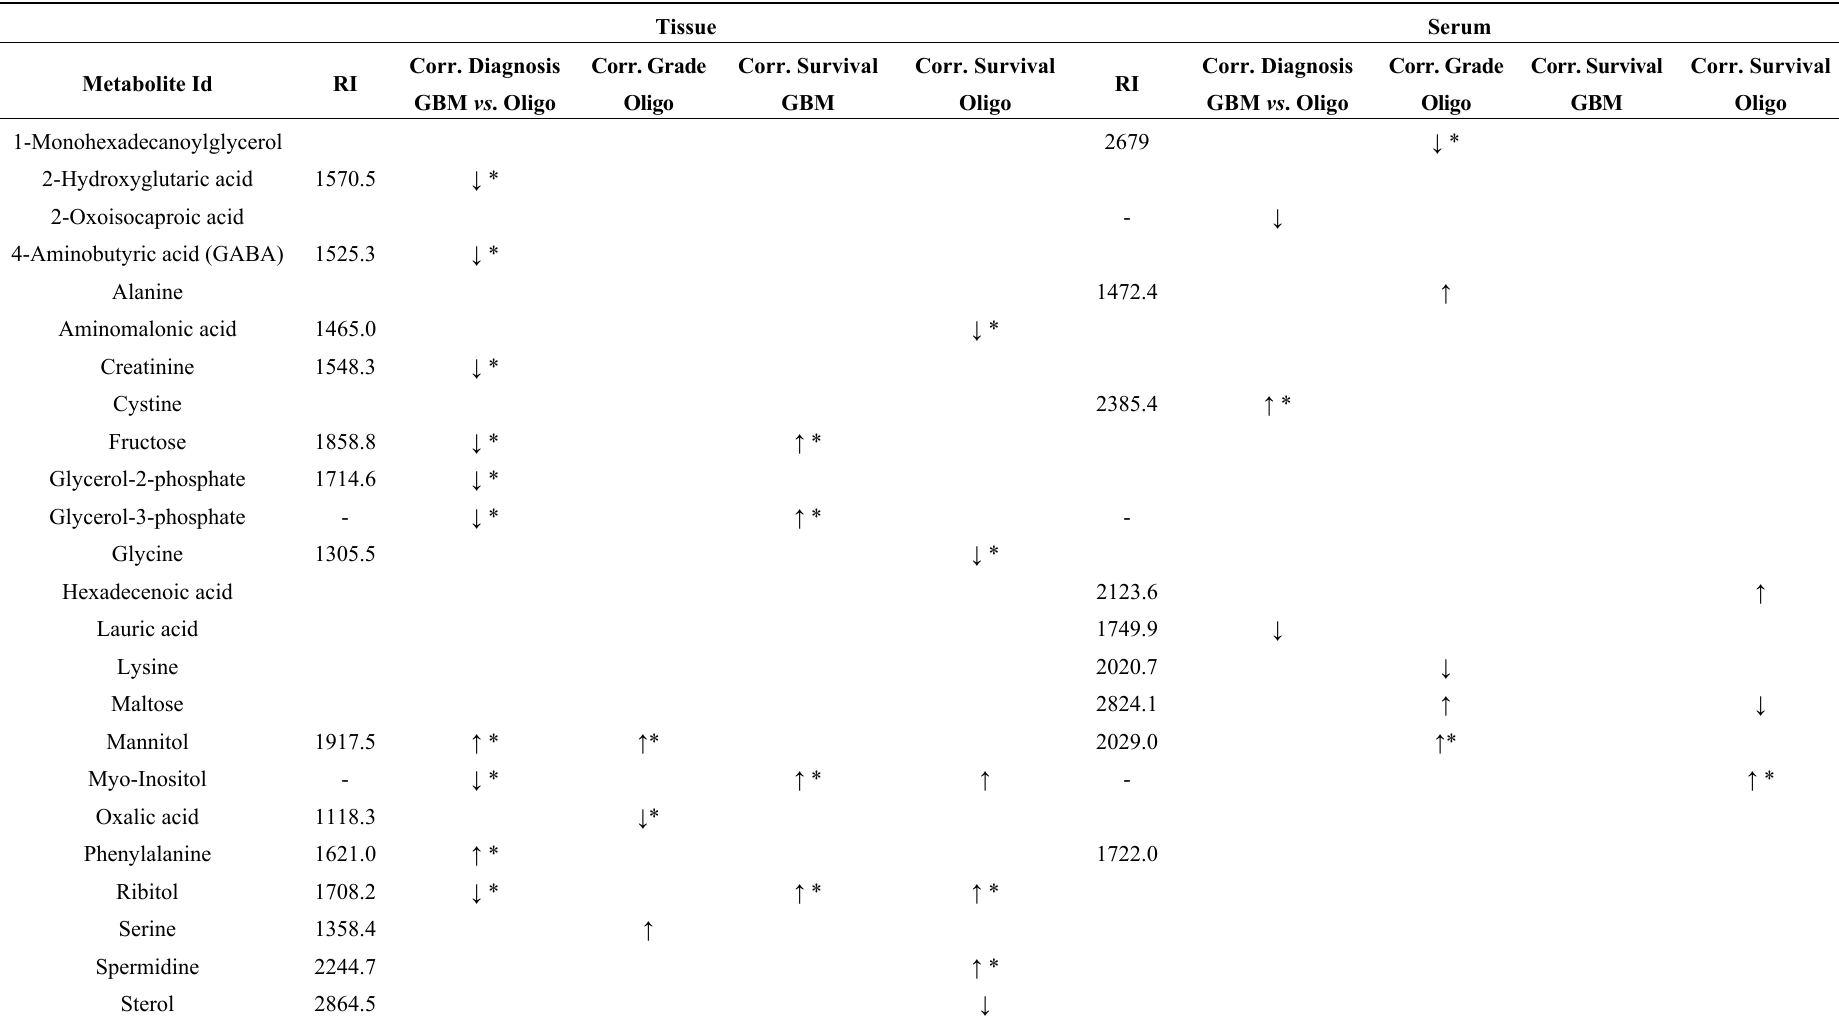
Table 1. Metabolic features altered in multivariate